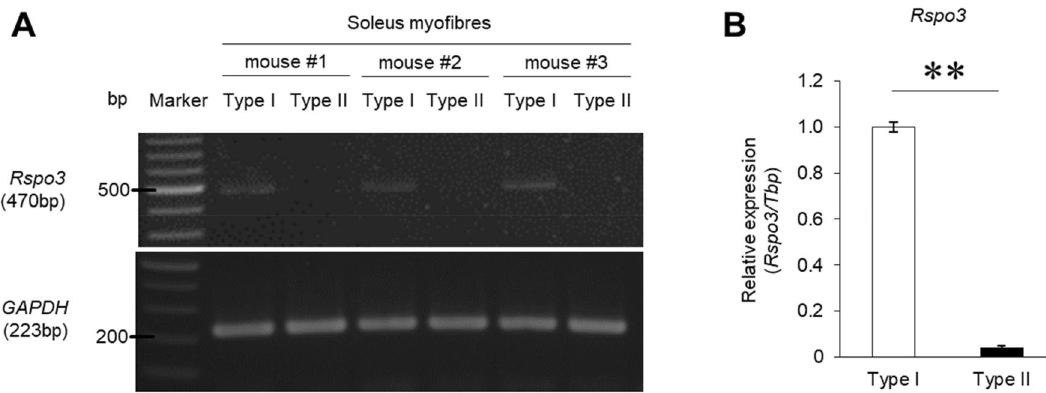
Figure 1. Rspo3 is specifically expressed in type I fibres. ( A ) The mRNA expression of the Rspo3 gene was analysed in type I and II fibres (n = 3) using conventional RT-PCR. ( B ) The mRNA expression level of Rspo3